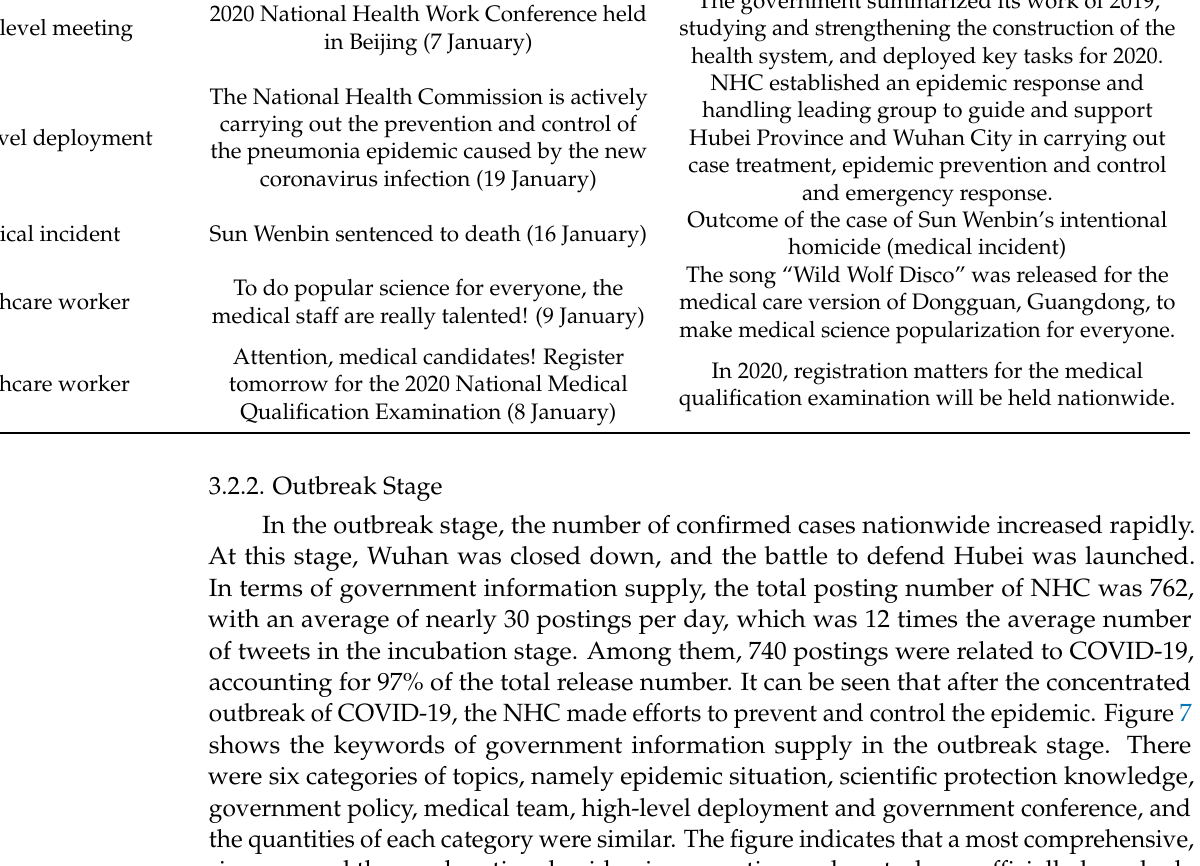
Table 2. Postings with high public attention in the incubation stage (top five).